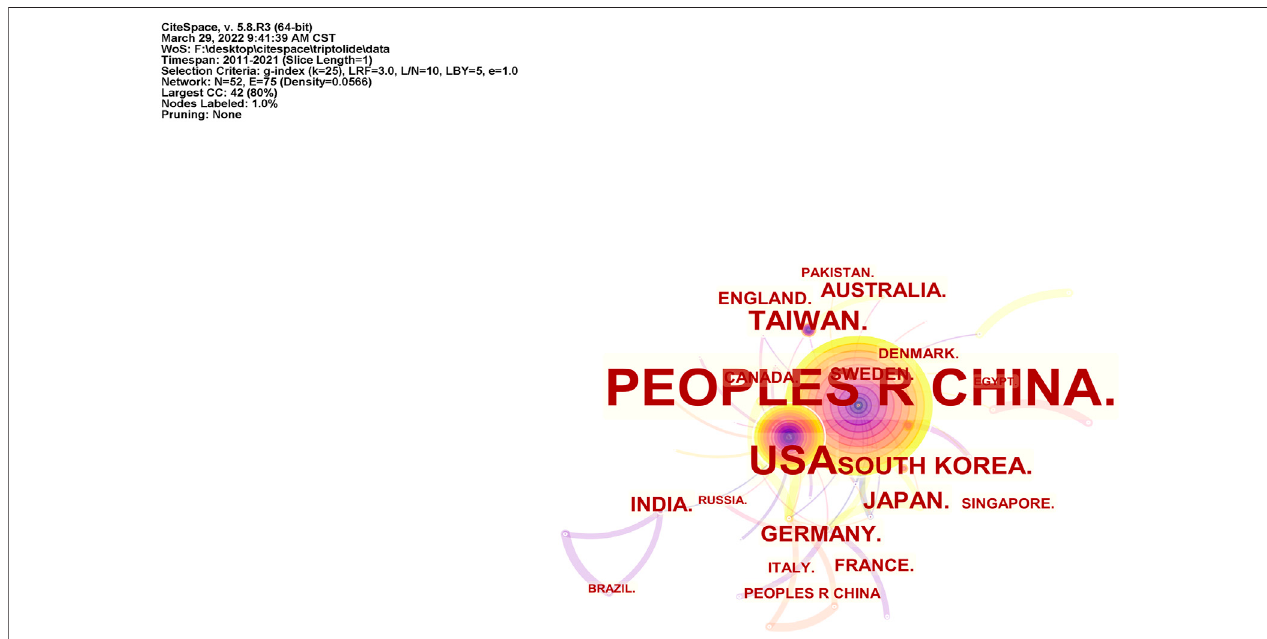
FIGURE 4 | Co-countries network of triptolide literature keywords from the